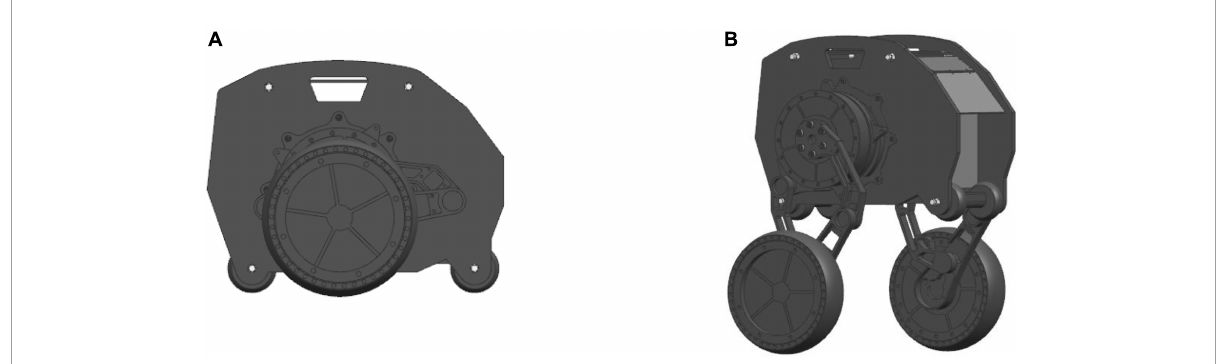
FIGURE2 Schematic diagram of robot motion posture: (A) Wheel movement mode; (B) Wheel-leg movement mode.